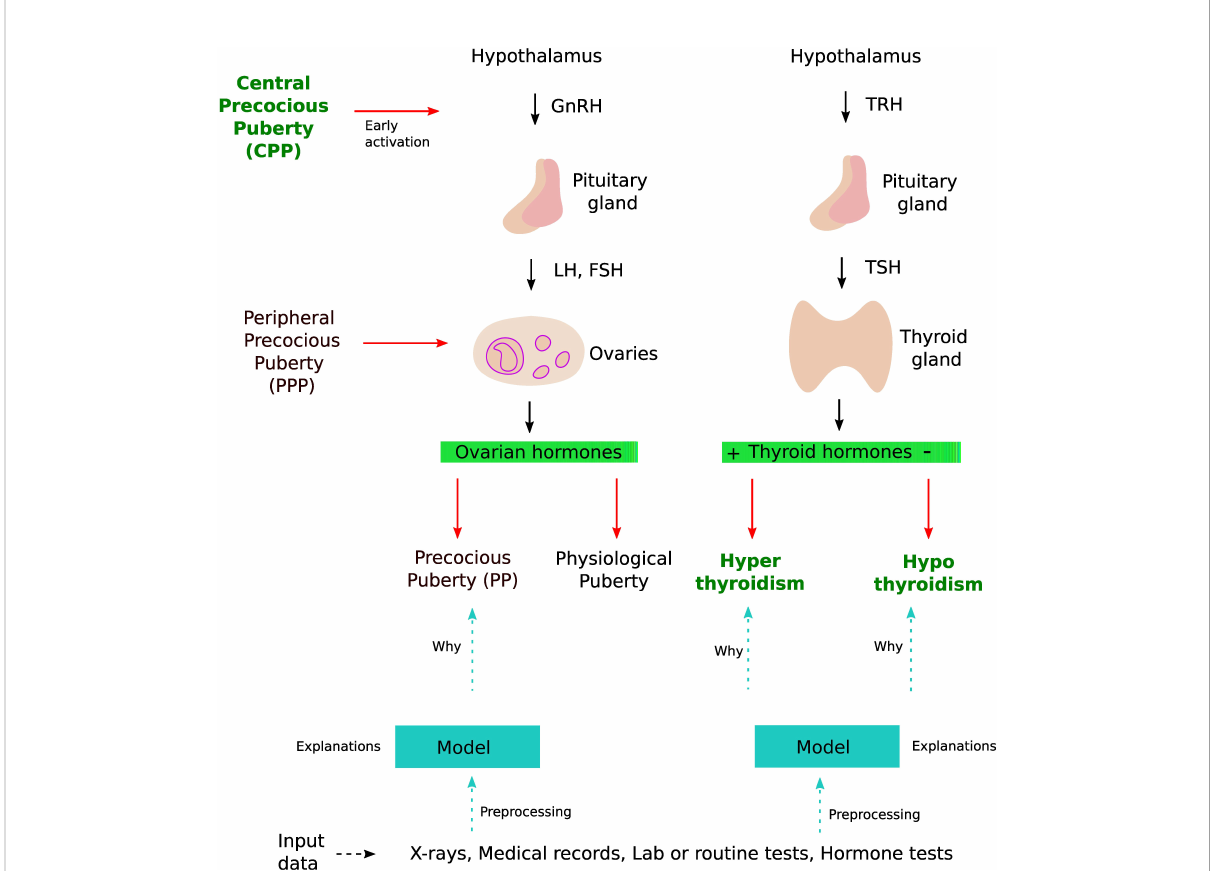
FIGURE 1 DL application in thyroid dysfunction and precocious puberty. The process starts with building a model from different data sources such as x- rays, medical records, and lab tests. Preprocessing is performed on the dataset to handle issues highlighted in section 4 (Considerations). To understand the internal mechanism of the DL model, one can use different explanation methods as discussed in section 4.5 (The black box